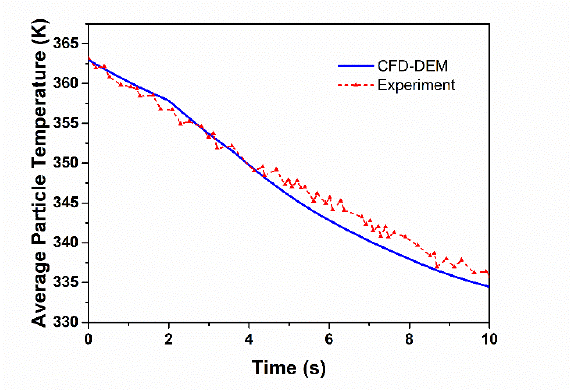
Figure 7. Comparison of the numerical results of the mean temperature to the experimental results